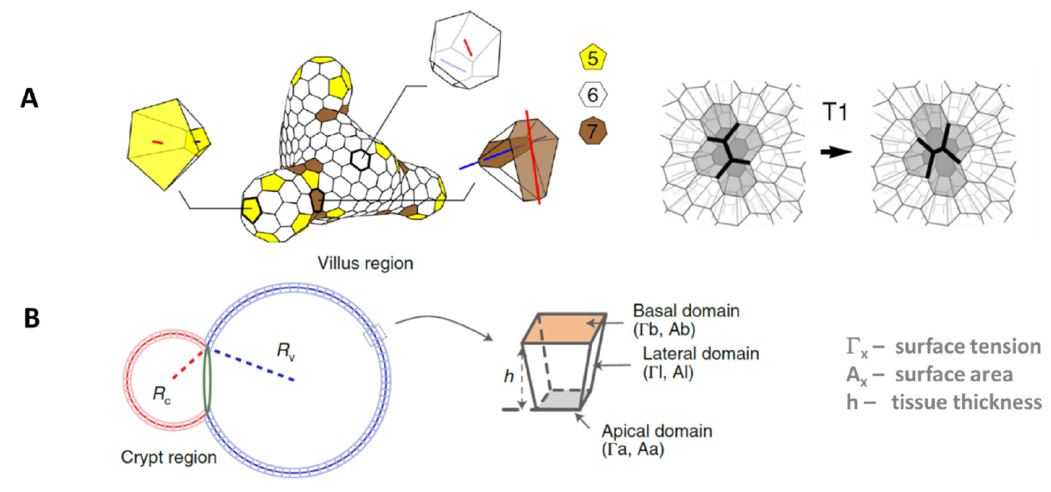
Figure 3. Vertex models of organoid-like cell aggregates. ( A ) Organoids in the model by Rozman et al. [27] have a flexible shape. The cells can have different numbers of neighbors. Examples of 5-, 6- and 7-coordinated cells are magnified. Interconversions can occur via so-called active T1 transitions that change the connectivity of the apical network (top view), followed by an update of the basal network and the lateral sides. ( B ) Schematic of the organoid model introduced by Yang et al. [31]. Two hollow spheres in contact represent the crypt (radius R c ) and villus region (radius R V ). Each cell has four neighbors. Due to the positive curvature, the apical surface of each cell, which is directed towards the lumen, is smaller than its basal surface. Figure 3B is published under Creative Commons CC-BY-NC-ND, all rights are reserved by the publisher.